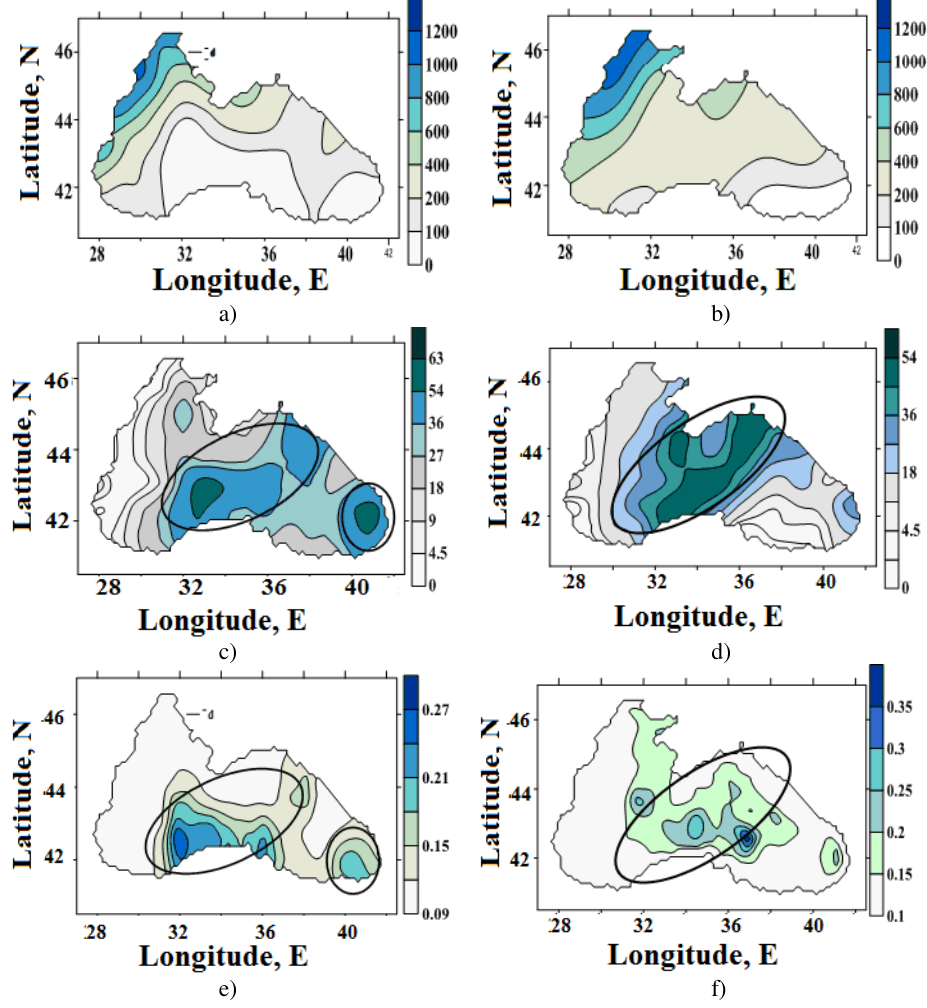
Figure 5. The average IFN content in the upper 10m layer of the sea in warm (a) and cold part of the year (b) (mgNm − 2 ), the deposition of IFN with atmospheric precipitations at the surface of the Black Sea in 12 August 2004 (c) and in 29 January 2007 (d) (mgNm − 2 ) the ratio of the deposited amount of IFN to its average content in the upper 10m layer of water (e, f) . Oval figures represent regions of significant contributions to the IFN content in